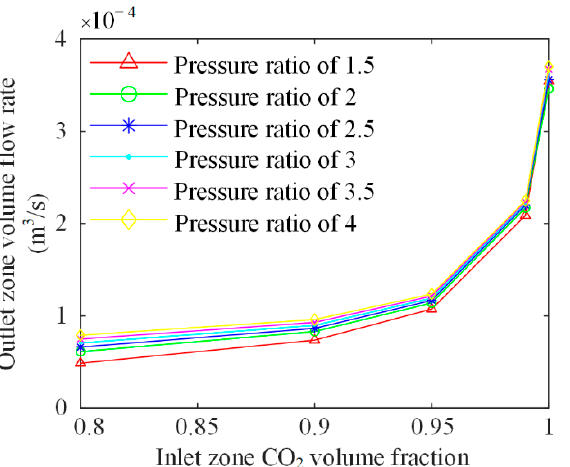
Figure 14. Pressure, velocity, and water volume fraction contours under the conditions of a pressure ratio of 2 and an inlet CO 2 volume fraction of 0.8 (not in scale). ( a ) pressure contours; ( b ) velocity contours; ( c ) water volume fraction contours.